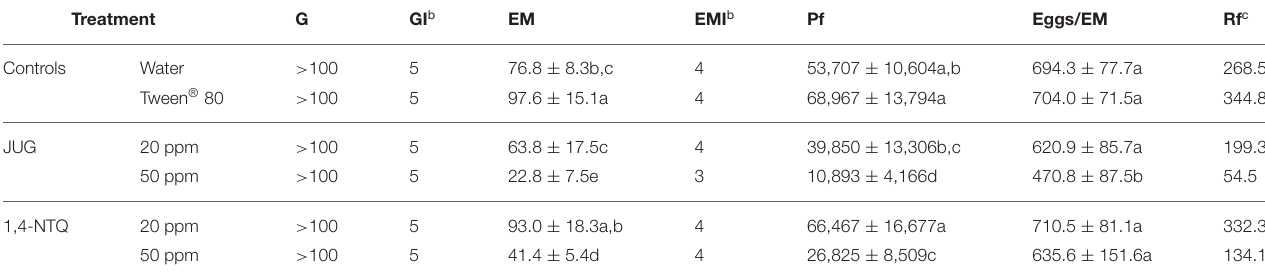
TABLE 3 | Number of galls (G) and egg masses (EM) and respective indices (GI, EMI), final population density (Pf), number of eggs/EM, and reproduction factor (Rf) of Meloidogyne luci , 45 days after inoculation a . Treatment G GI b EM EMI b Pf Eggs/EM Rf c Controls